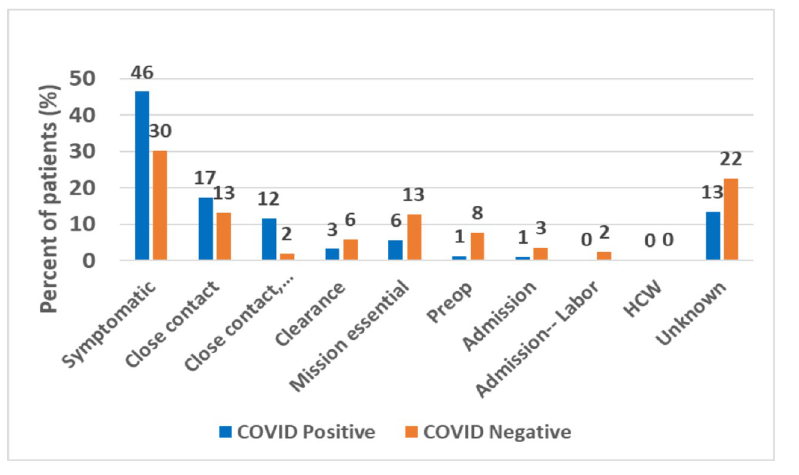
Fig 3. Reason for testing.